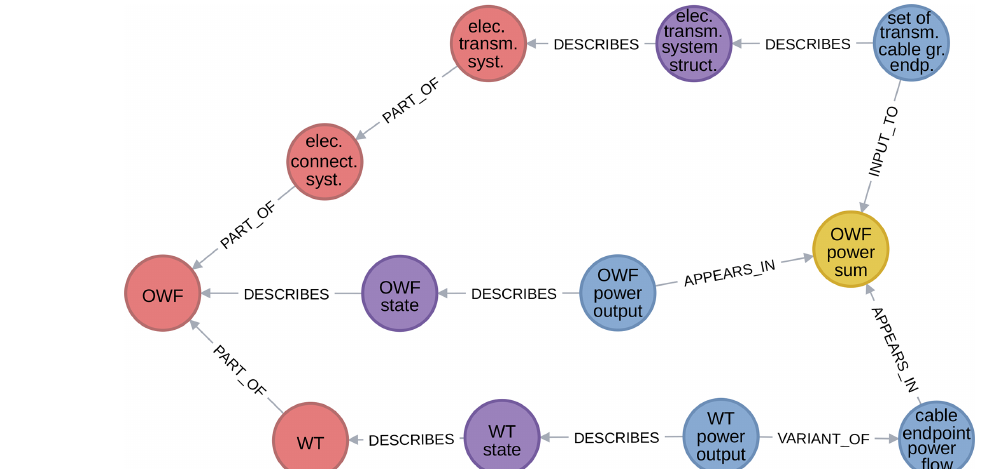
Figure 1. Visualization of an excerpt of the content in WESgraph.